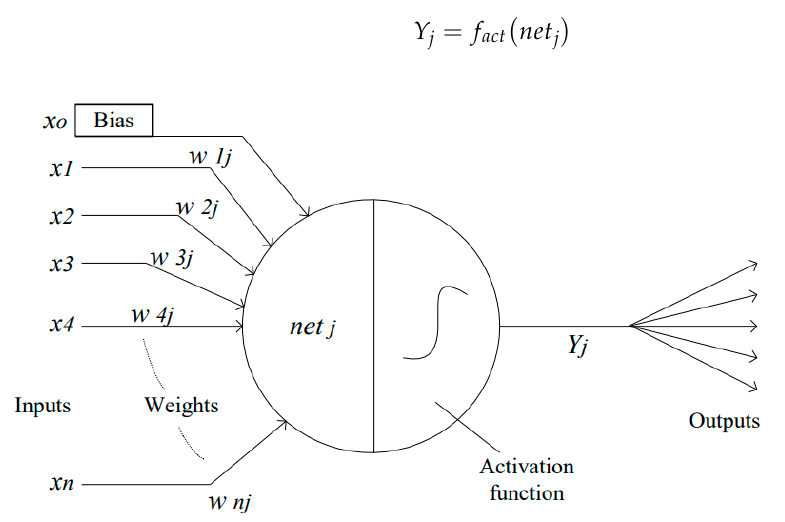
Figure 5. Individual neuron structure of the ANN